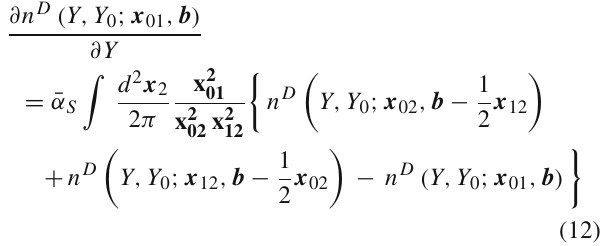
where ψ( x ) = d ln (cid:17)( x )/ dx and (cid:17) is the Euler gamma